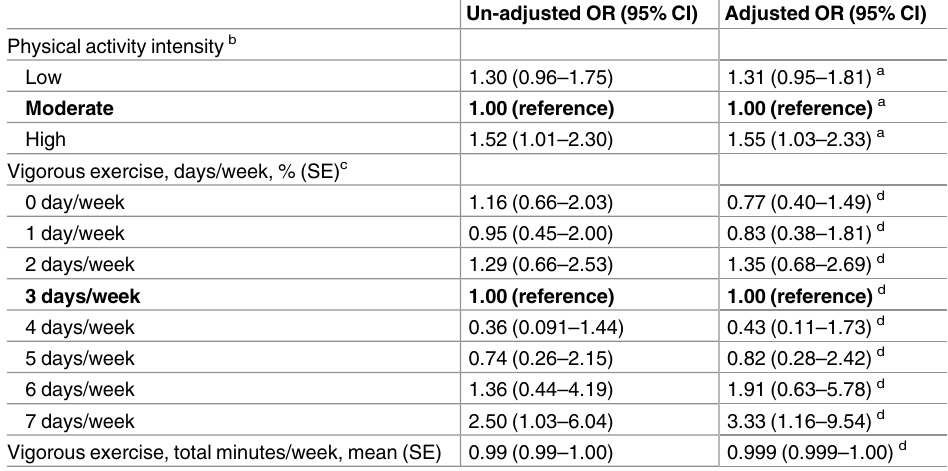
Table 4. Odds ratios (OR) and 95% confidence intervals (CI) for the presenceof glaucoma among dif- ferent levels of physical activity and frequency of vigorous exercise.